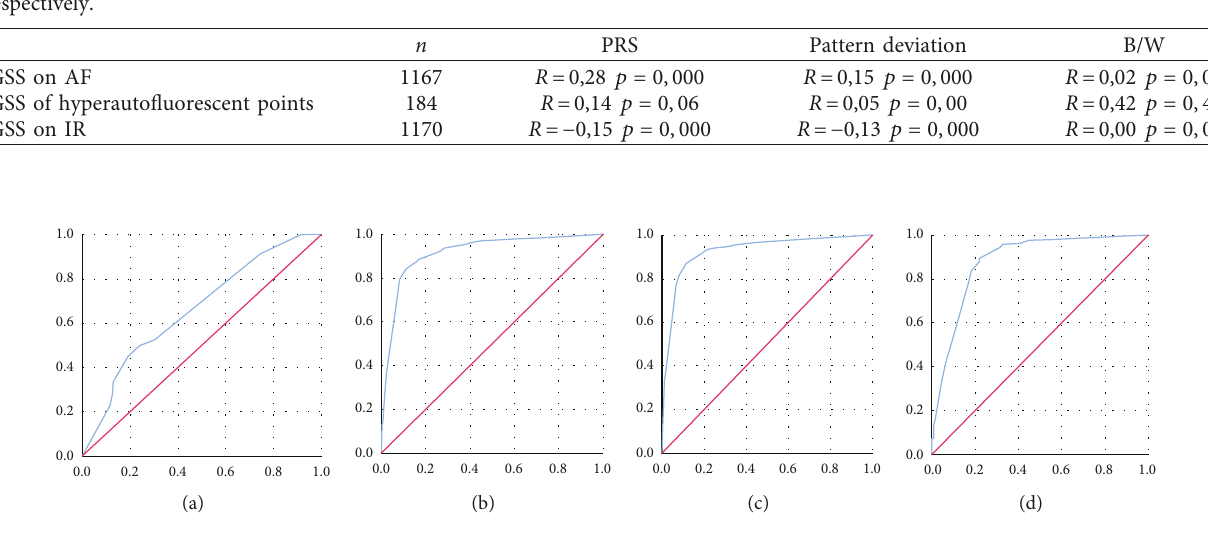
Figure 3: The AUC-ROC score and corresponding confidence intervals are shown in the plot as follows: AOU score of 0,917 between CMP fundus photo and CMP perimetric scores (a) indicates a very high sensitivity and specificity of CMP to individuate retinal atrophic regions. The AOU-roc curve between CMP perimetric values and CMP IR was 0,926, (b) the AOU-roc curve between CMP perimetric scores and AF Heidelberg was 0,663, and (c) the AOU-roc curve between CMP and IR Heidelberg was 0,882 Table 4: K Cohen correlation between all the variables.